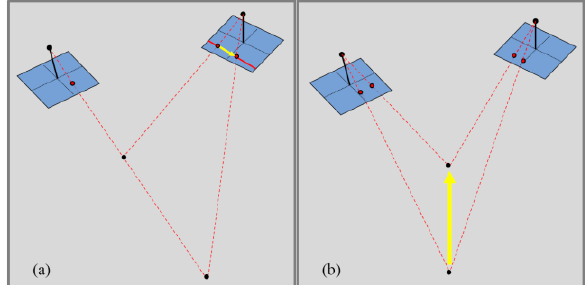
Figure 1. Illustration of 3D point determination by a one- dimensional search, a) an image-space search along the epipolar line using the radiometric information directly, b) the search is along the vertical locus, and the radiometric values are obtained by projection to image-space. The positioning in both cases is motivated by requiring minimal values for the intensity differences.